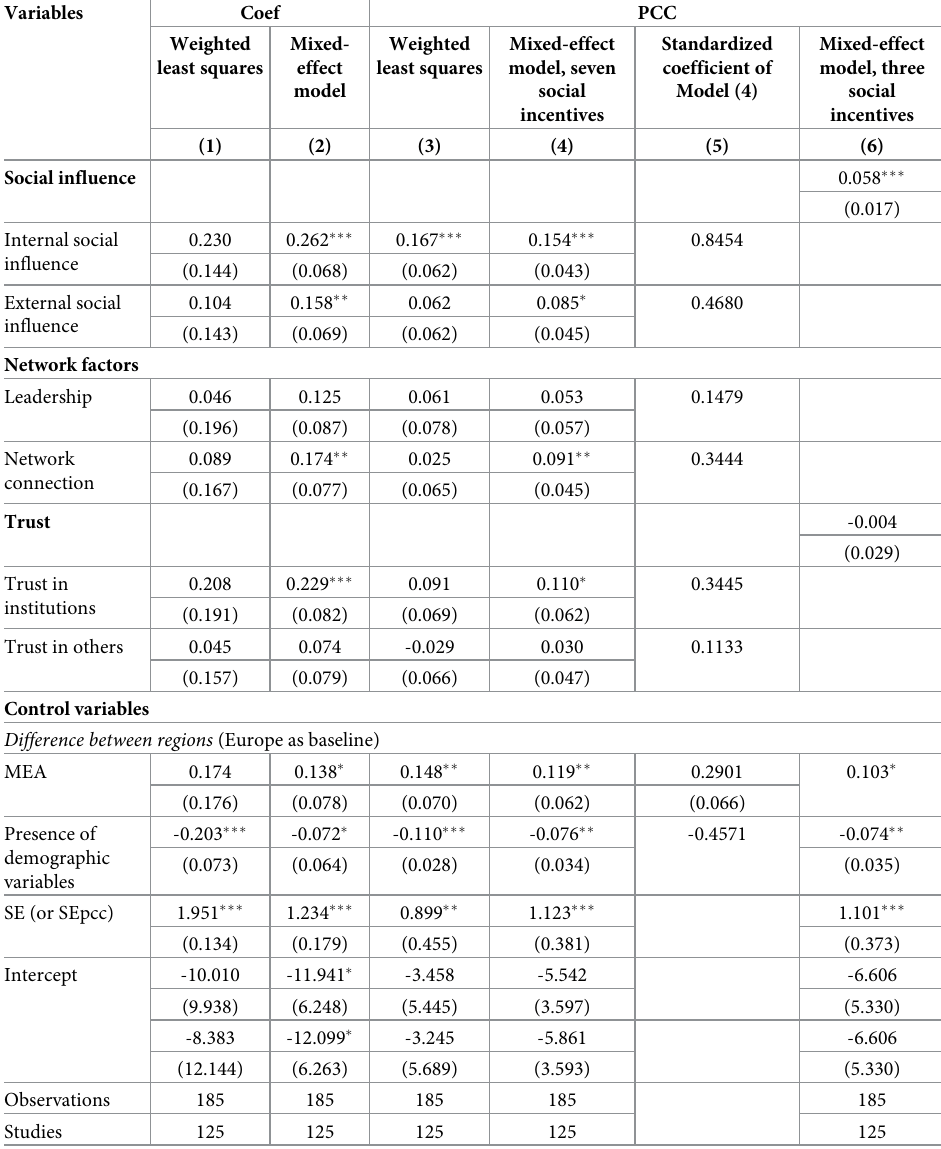
Table 3. A brief summary of the meta regression